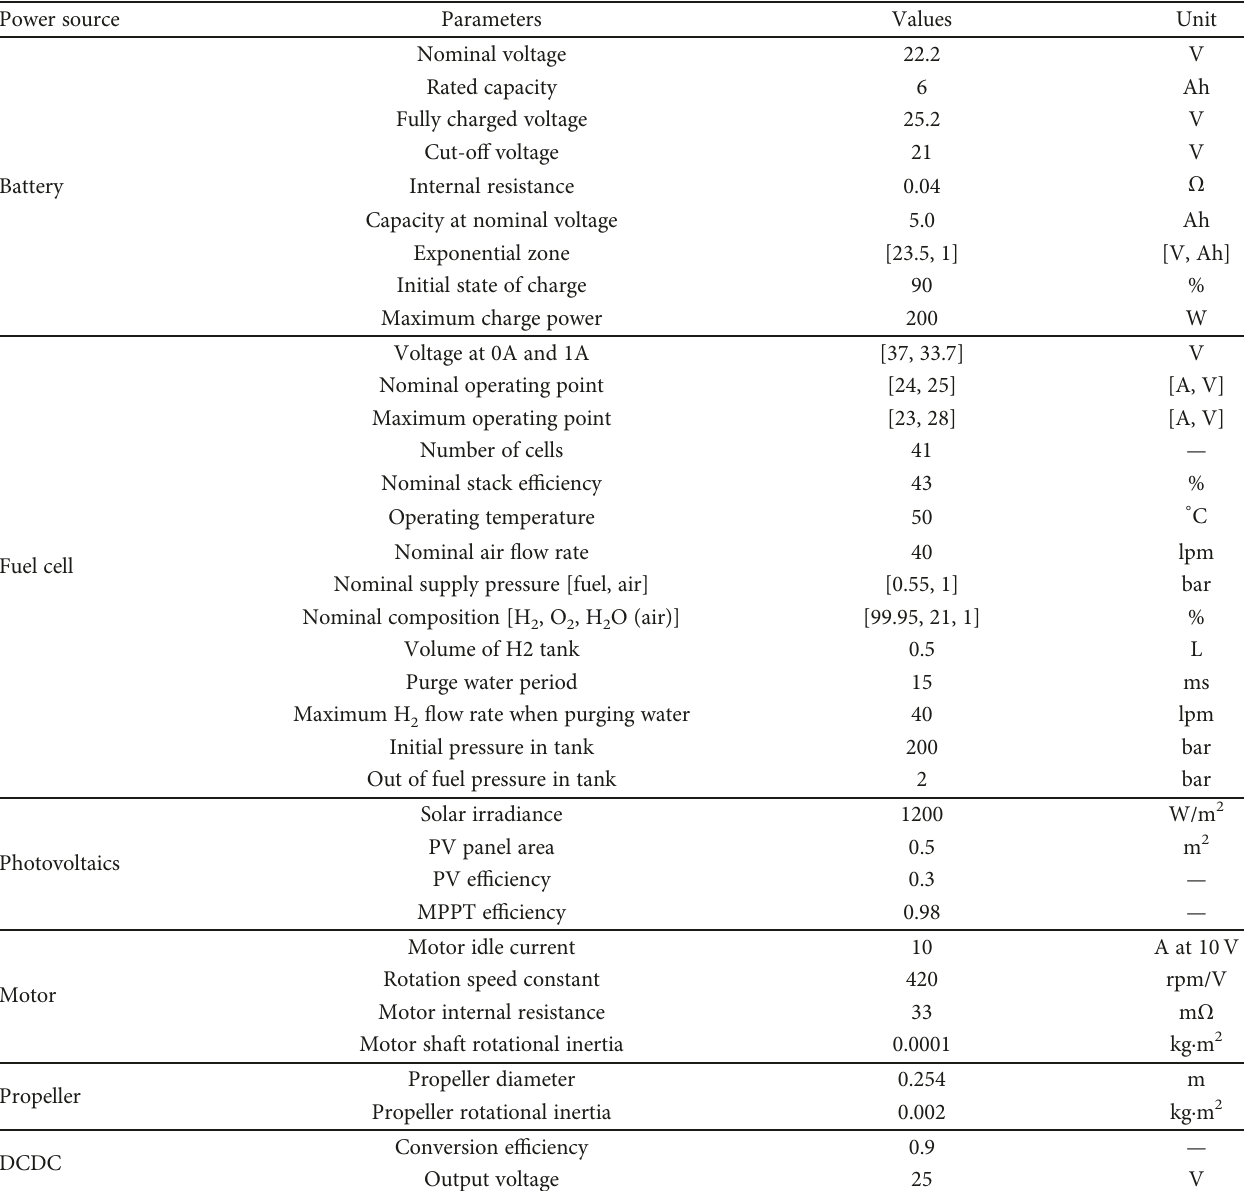
Table 4: Initial parameters of the hybrid power